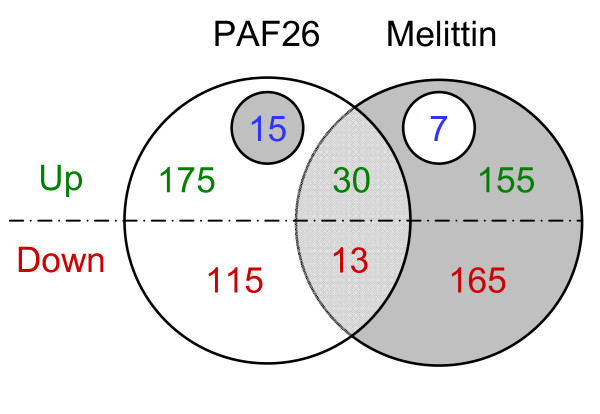
Distribution of differentially expressed genes after peptide treatment. A z-test for two independent conditions was conducted for each peptide treatment compared to the control treatment. Effective p-values were <3.3E-03 and <3.7E-03 for PAF26 and melittin, respectively. Diagram shows genes induced (up) or repressed (down) by peptides. The small circles on the upper part refer to 15 genes induced by PAF26 and repressed by melittin and 7 genes induced by melittin and repressed by PAF26.